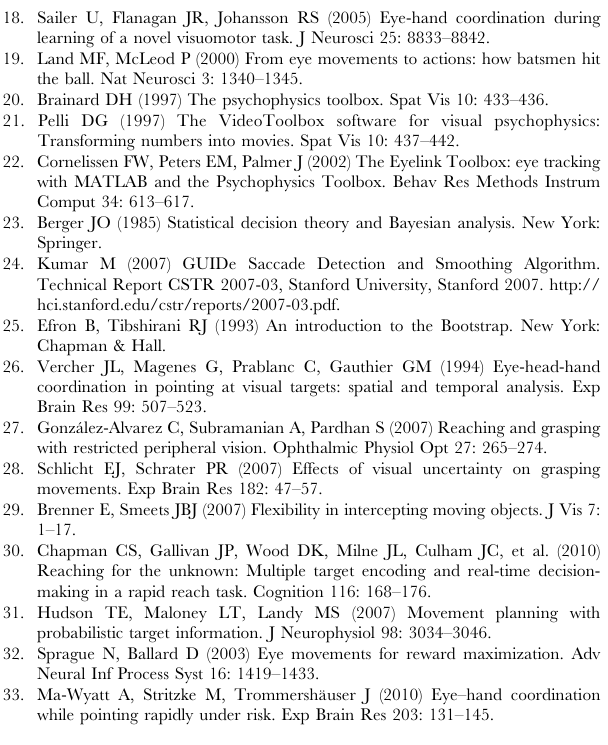
Figure S2 Movement speed: reach training vs. search- reach. Figure S3 Histogram of the movement time after the target was found (post-found time). Figure S4 Percentage of specific search orders used by each observer.